Question: What style of plot is this figure drawn as?
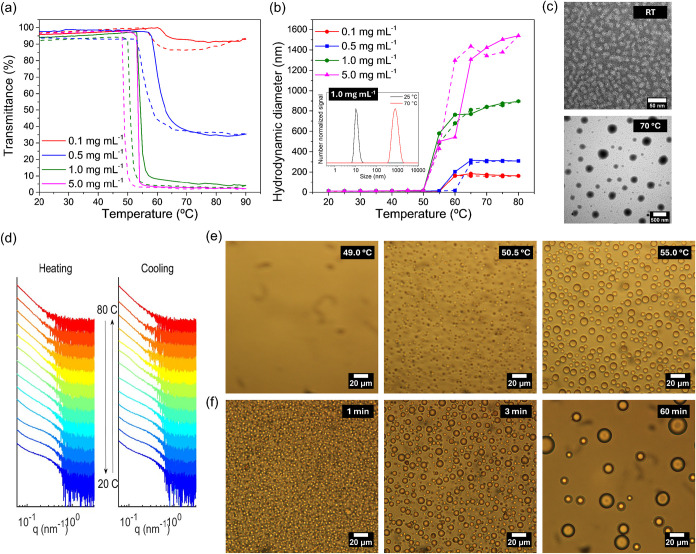
Answer: line